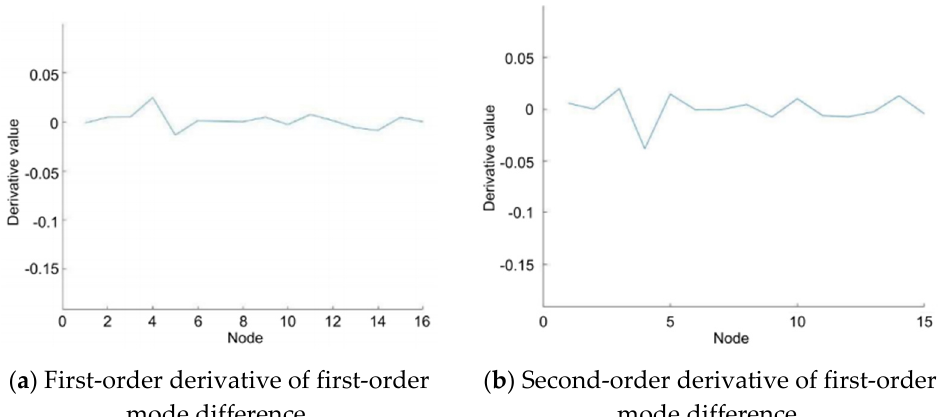
Figure 17. Difference derivatives under the Conditions 1 (single-span nondamaged) and 4 (single- span double-damage).